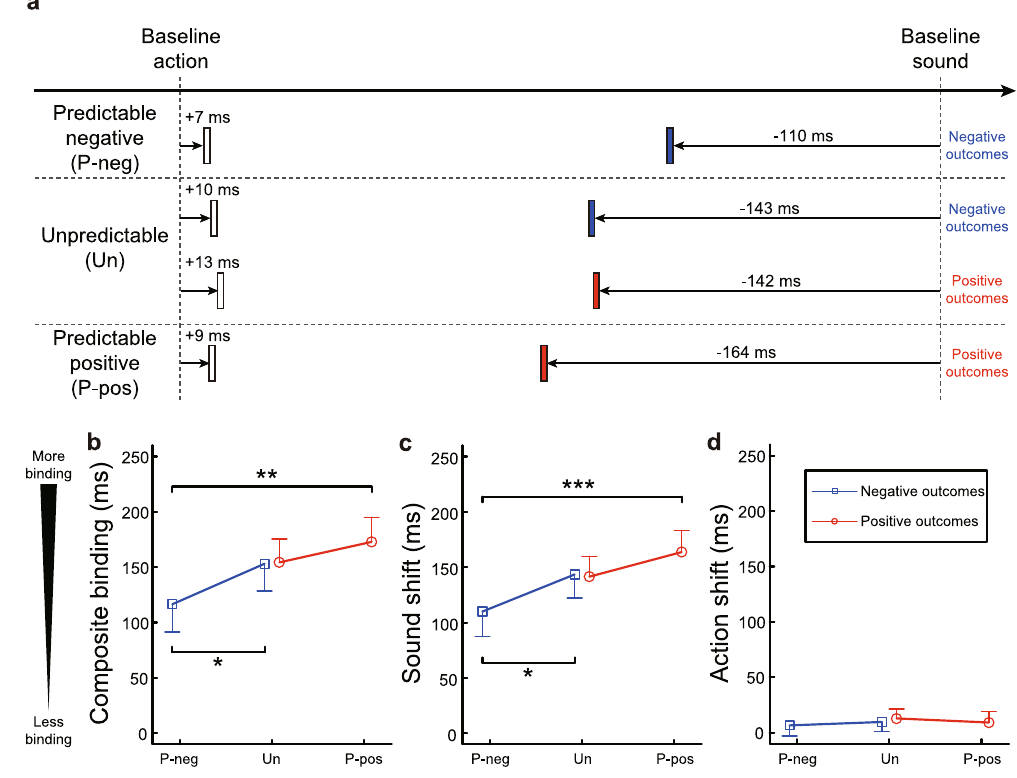
Figure 2. Measures of intentional binding in each emotional condition. ( a ) Summary of the results. ( b ) Means of the composite binding. ( c ) Means of the sound shift (sign-reversed for illustration purposes). ( d ) Means of the action shift. Data are represented as mean ± SEM. P-neg = predictable negative condition; Un = unpredictable condition; P-pos = predictable positive condition. * P < 0.05; ** P < 0.01, *** P <